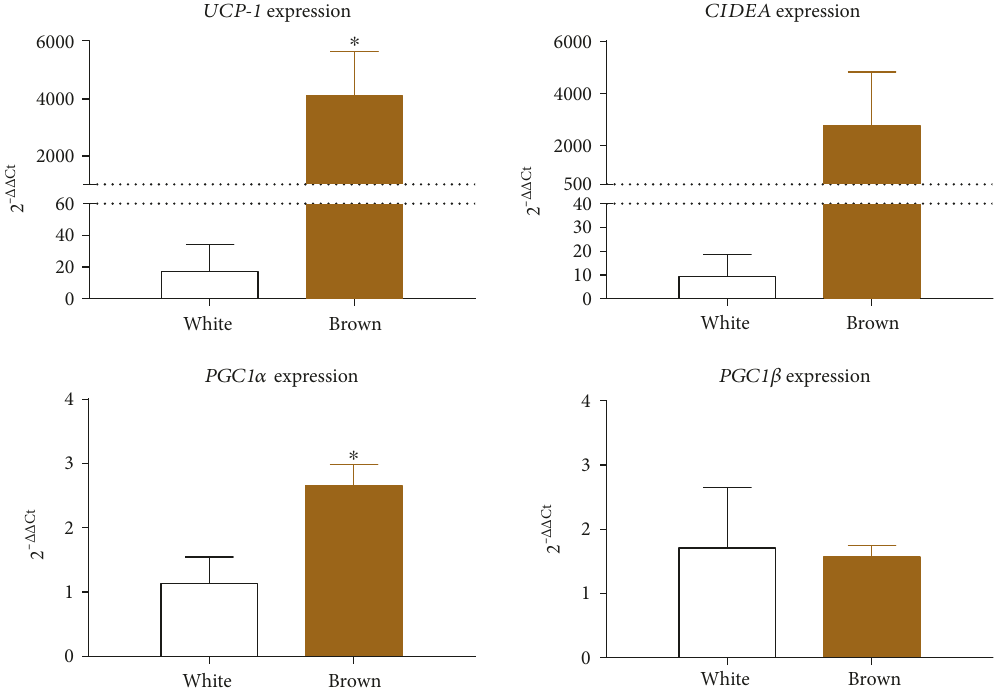
Figure 1: Characterization of white and brown adipocytes. Preadipocytes were cultured for 24 hours prior to di ff erentiation for 10 days as described in Section 2. After 10 days, gene expression of UCP-1 , CIDEA , PGC1 α , and PGC1 β was assessed by qRT-PCR from 2 to 3 biological replicates of adipocytes cultured in separate wells. Bar graphs represent mean +SEM of N =2-3 biological replicates of the same adipocyte clone. Student ’ s t -test, ∗ p < 0 05